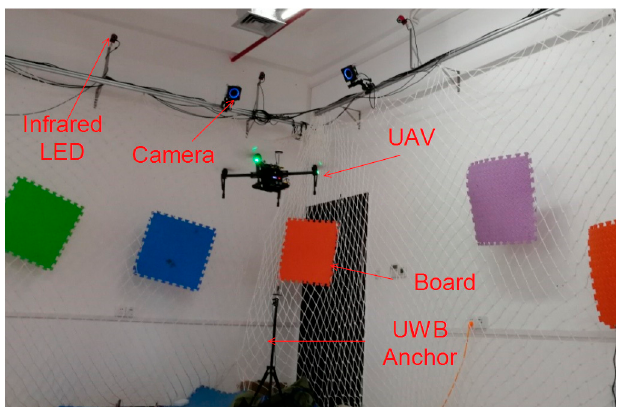
Figure 10. Experiments with a motion capture system [27].